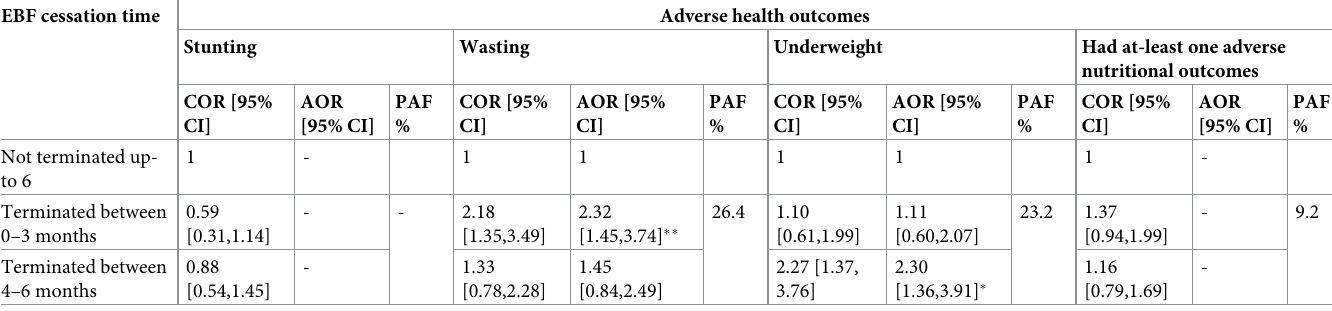
Table 4. Effect of exclusive breastfeeding on nutritional outcomes among children, 2011 and 2016 EDHS, Ethiopia. EBF cessation